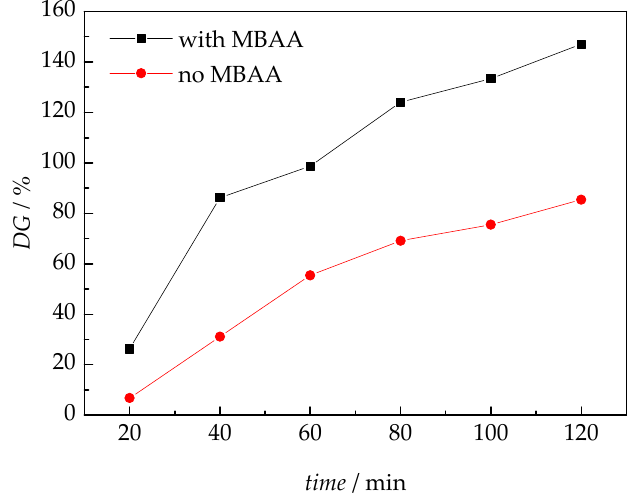
Figure 1. Influence of the crosslinker on the development of the DG with time for x 1 = 80 °C, x 2 = 40 vol %, x 3 = 50 kGy with 85 mol % GMA, 10 mol % HEMA, and 5 mol % MBAA.